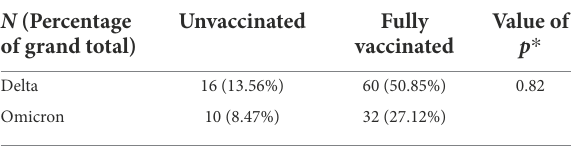
TABLE 6 Contingency table of SARS-CoV-2 variant vs. unvaccinated/ fully vaccinated status. N (Percentage of grand